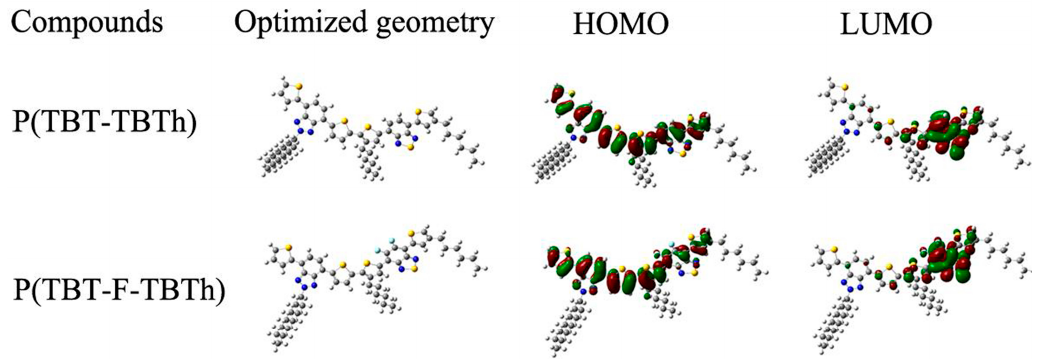
Figure 7. Optimized geometries and molecular orbital surfaces of the HOMO and LUMO for P(TBT-TBTh) and P(TBT-F-TBTh).